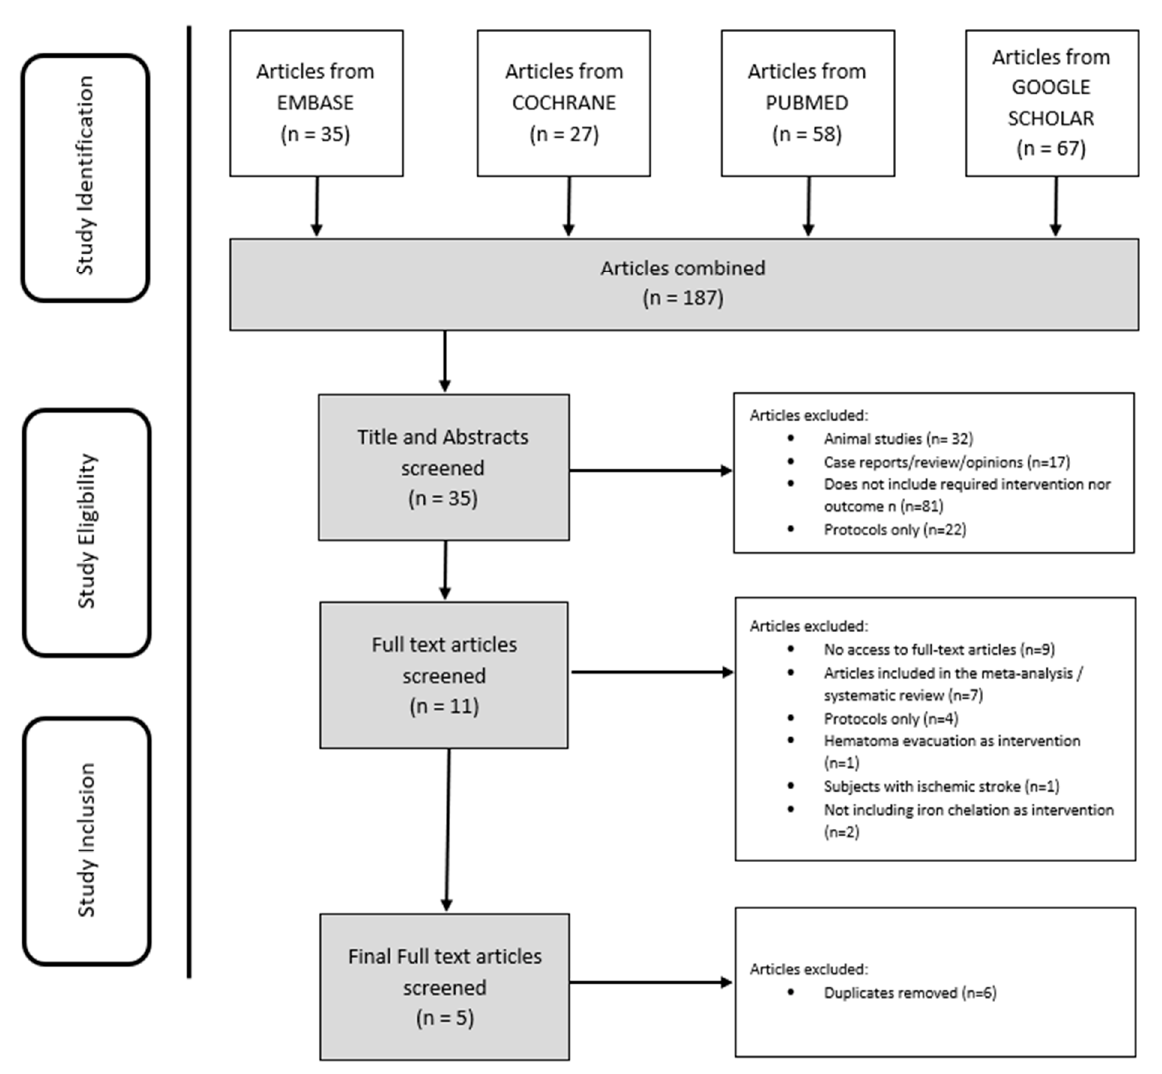
Figure 1. PRISMA Flowchart of Study Selection based on our eligibility criteria. On the other hand, the post hoc analysis of the intracerebral hemorrhage deferoxamine (i-DEF) trial by Wei et al. [16] was also included in our analysis. The article analyzed the efficacy of the 3-day course of intravenous deferoxamine 32 mg/kg per day in ICH patients based on the hematoma volume subgroups (small <10 mL, moderate 10–30 mL, and large >30 mL). By evaluating the i-DEF protocol, randomization and blinding were performed in